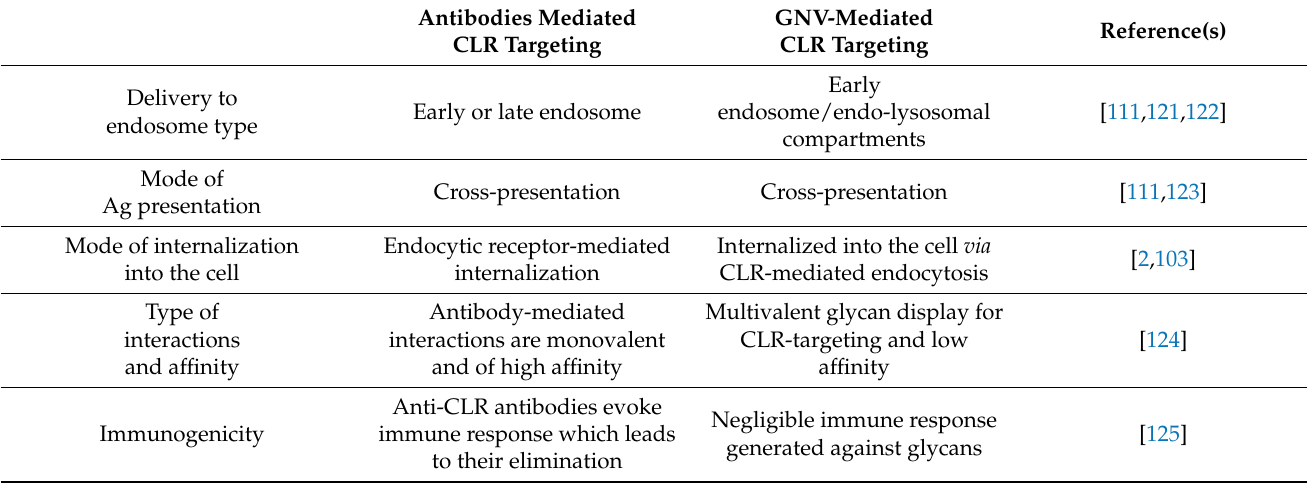
Table 1. Comparing antibody-mediated and GNV-mediated